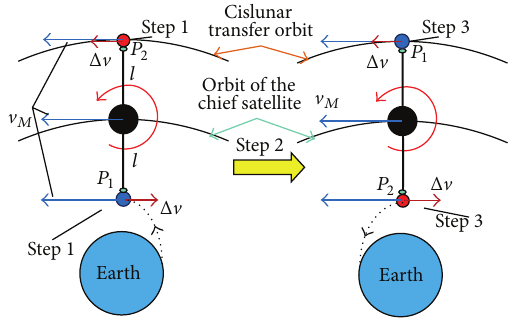
Figure 2: Schematic of a MMET transferring